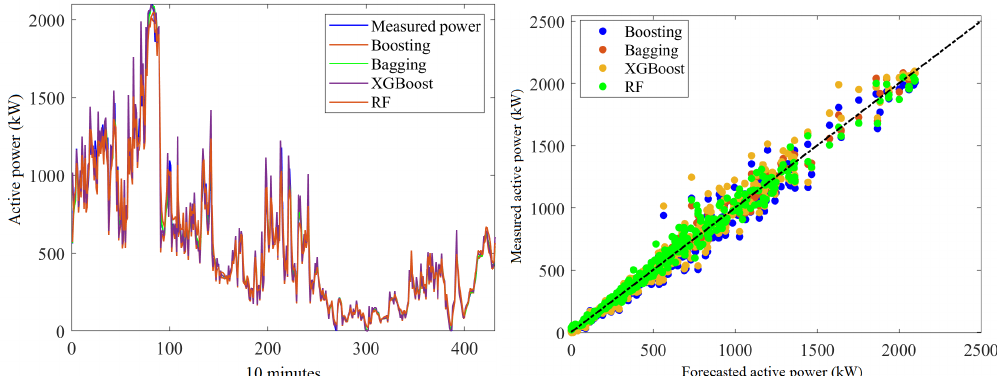
Figure 15. ( Left ) Predicted wind power from BT, BS, and XGBoost and RF models for the testing data from France. ( Right ) Scatter graphs of wind power prediction and